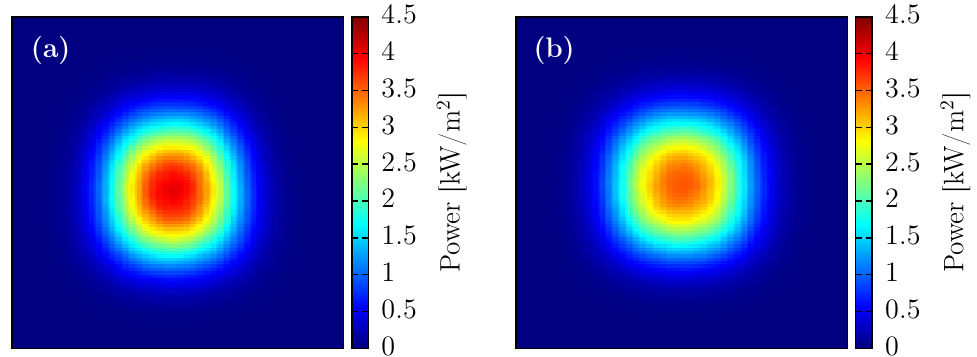
Figure 8. Concentrated solar flux distribution on the receiver (6m × 6m) for an H8 array located at 0.75 h (26.25 m). Solar noon the 21st of June ( a ) and December ( b ).